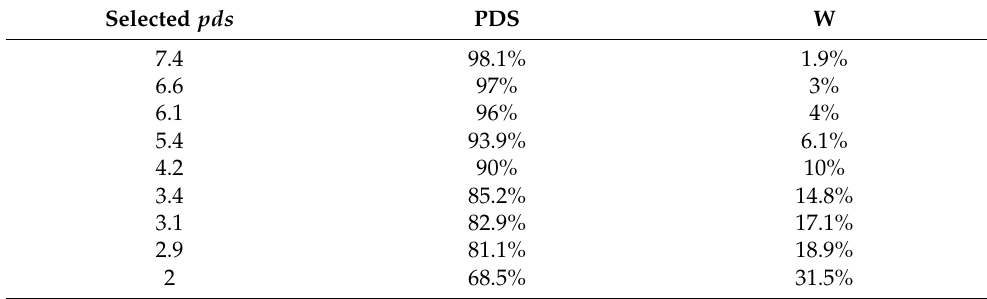
Table 13. Selection of pds activated and number of customers served as pds activation cost changes.